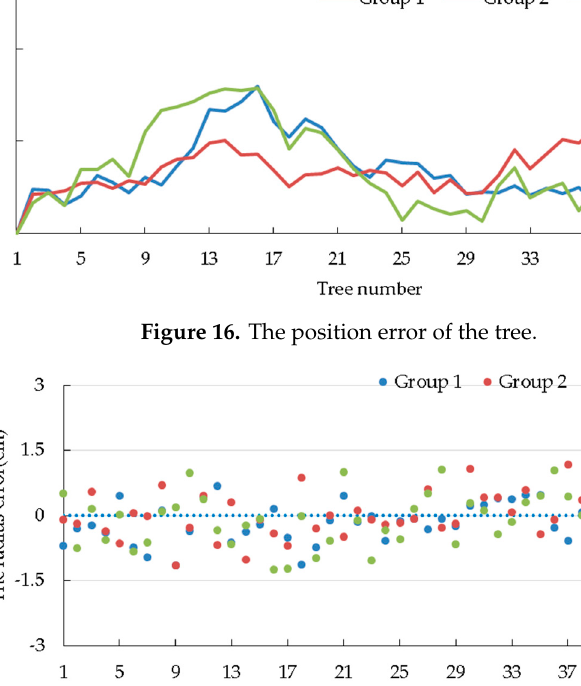
Figure 17. The radius error of the tree.